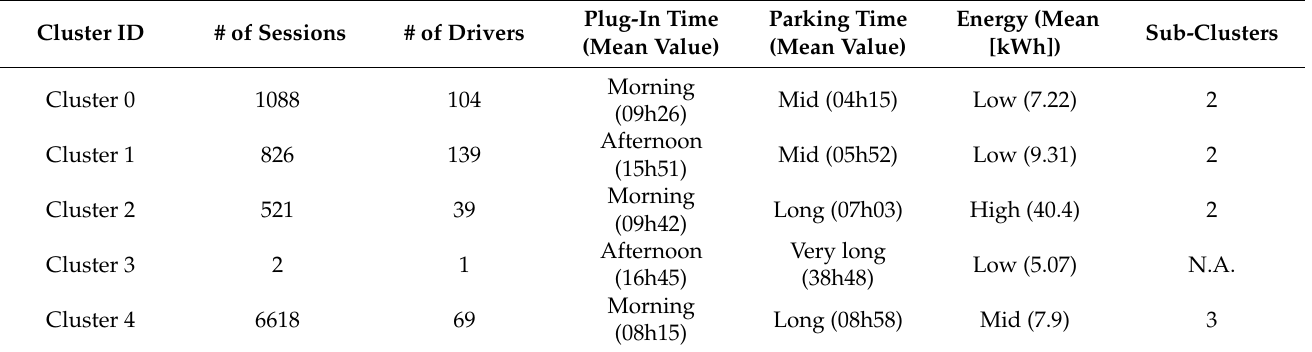
Table 2. Clusters’ quantitative